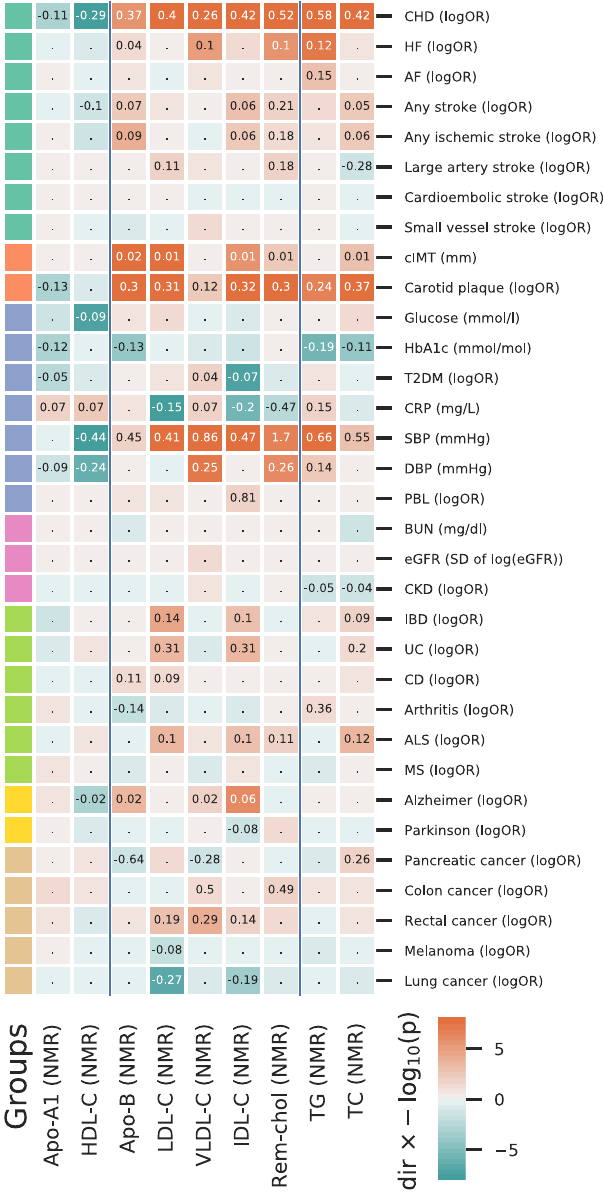
Fig. 2 for independent replication of the univariable ( total effects ) for LDL-C, HDL-C, and TG concentration.